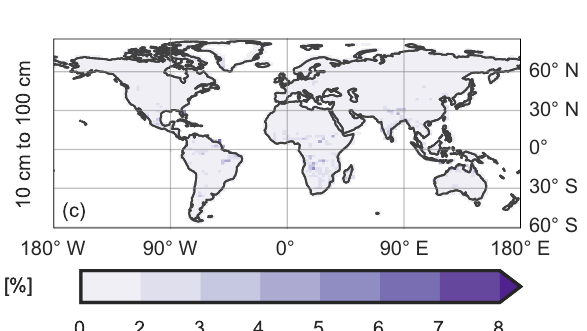
abcdefghijklmnopqrstuvwxyzQWERTZUIOPASDFGHJKLYXCVBNM0123456789 .,()/°-[]%: